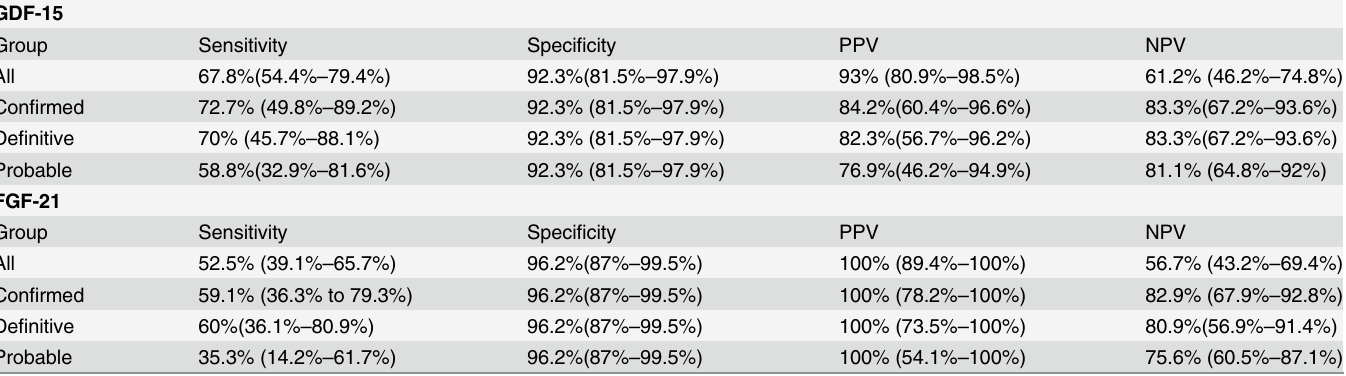
Table 2. Diagnostic performance of GDF-15 (A) and FGF-21 (B) for a cut-off value of 550pg/ml and 300pg/ml respectively. 95% confidence intervals are indicated in brackets.